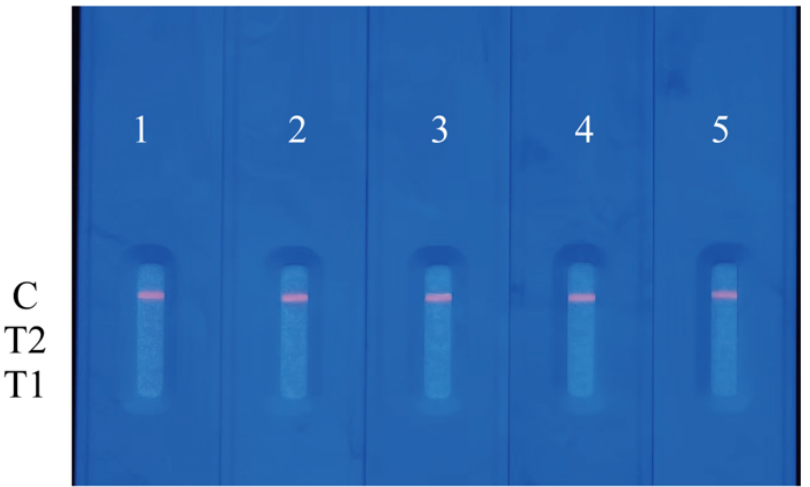
Figure 6. The cross-reactivity of FluB/SARS-CoV-2 QDFM ICTS and antigens of other pathogenic microbes. 1: blank; 2: the antigen of FluA; 3: the antigen of M.tuberculosis; 4: the antigen of Escherichia coli; 5: the antigen of salmonella typhi.